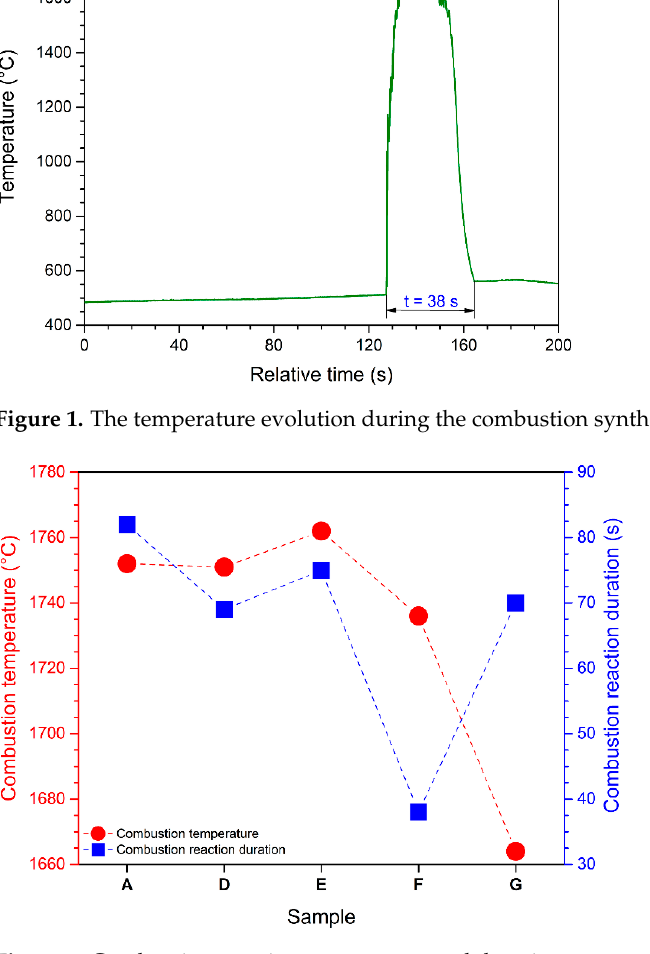
Figure 3. Images captured during the combustion reaction (sample E). Figure 4 shows the TG and DSC curves of precursor mixture F after water evapora- tion in the drying oven overnight (14 h at 105 °C). Figure 4. Thermal analysis of precursor mixture F. The XRD patterns of the samples prepared by combustion synthesis (Figure 5) show the diffraction peaks typical for SrAl 2 O 4 phase. The XRD pattern of a commercially avail- able SrAl 2 O 4 : Eu 2+ , Dy 3+ sample (CS) is also shown for comparison.